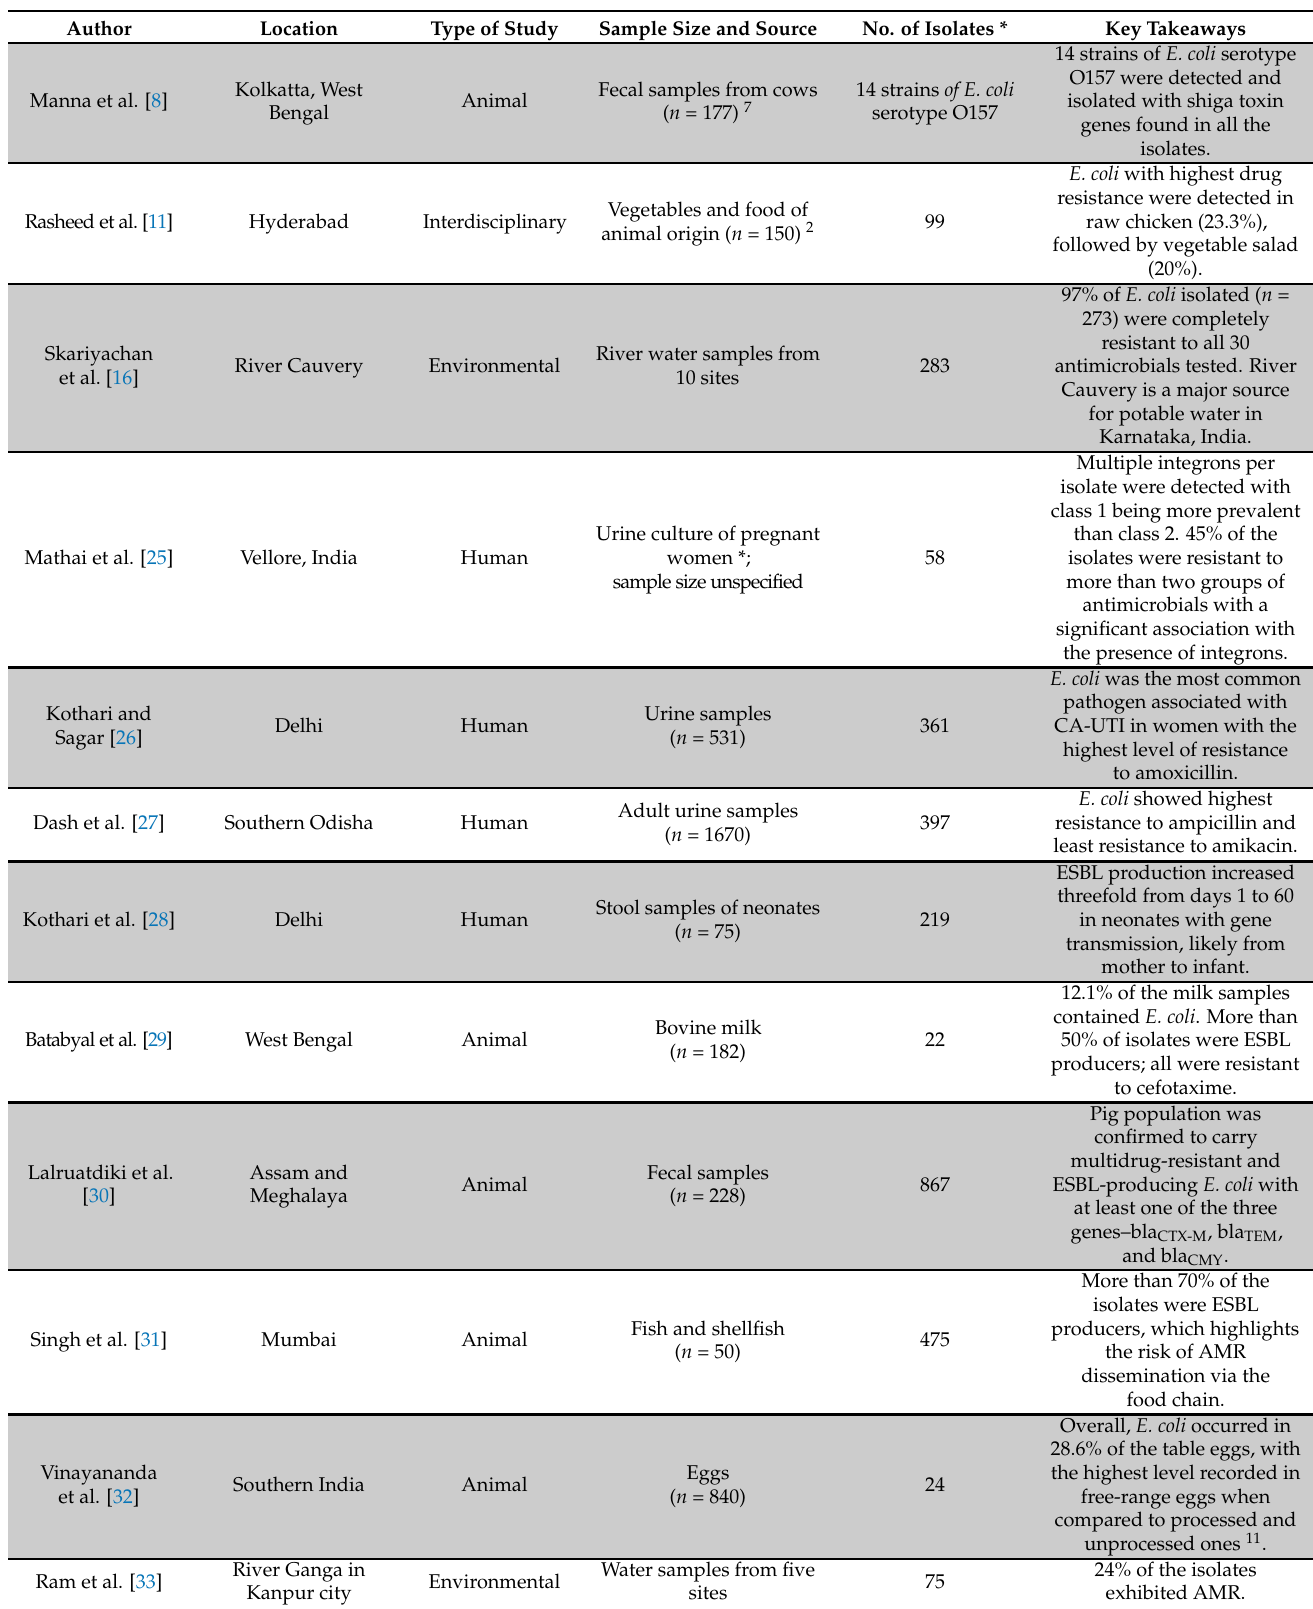
Table A2. Summary of the studies that assessed antimicrobial resistance in E. coli from environmental, animal, and human